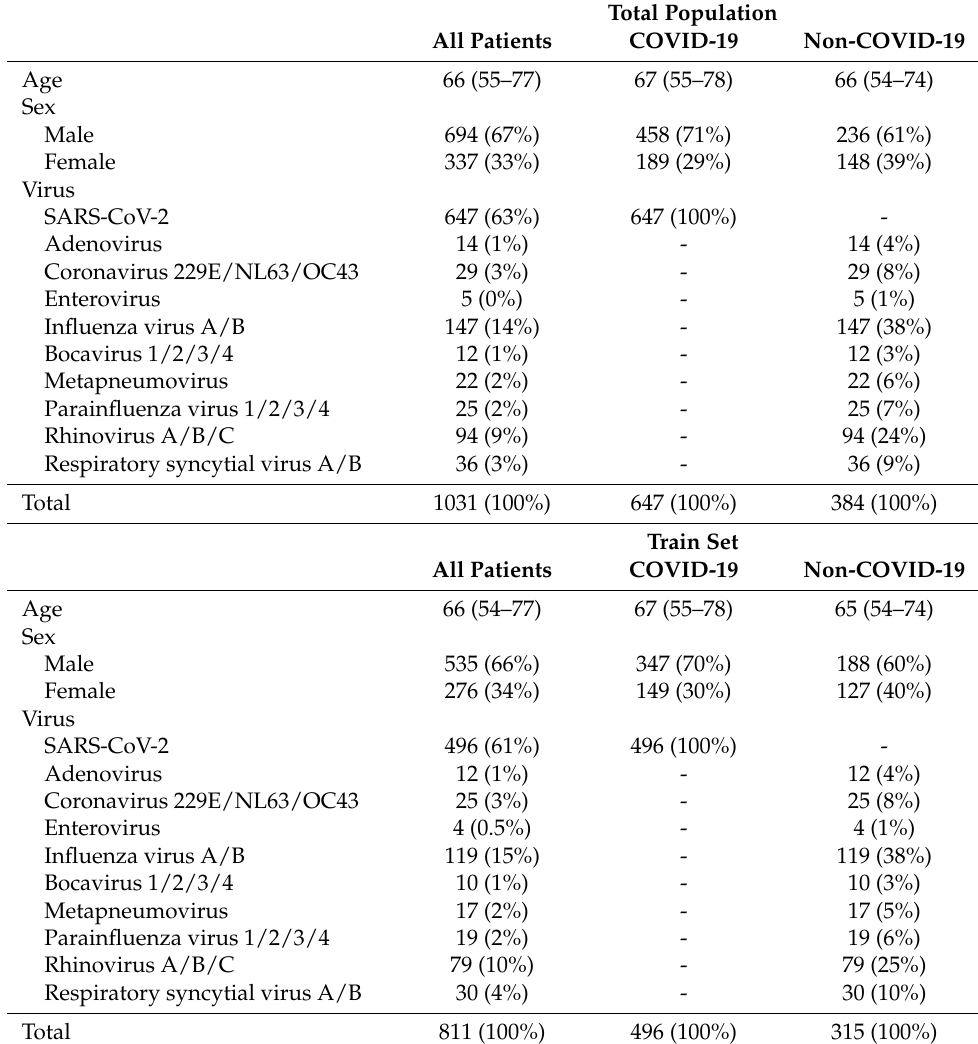
Table 1. Demographic characteristics of the study population.